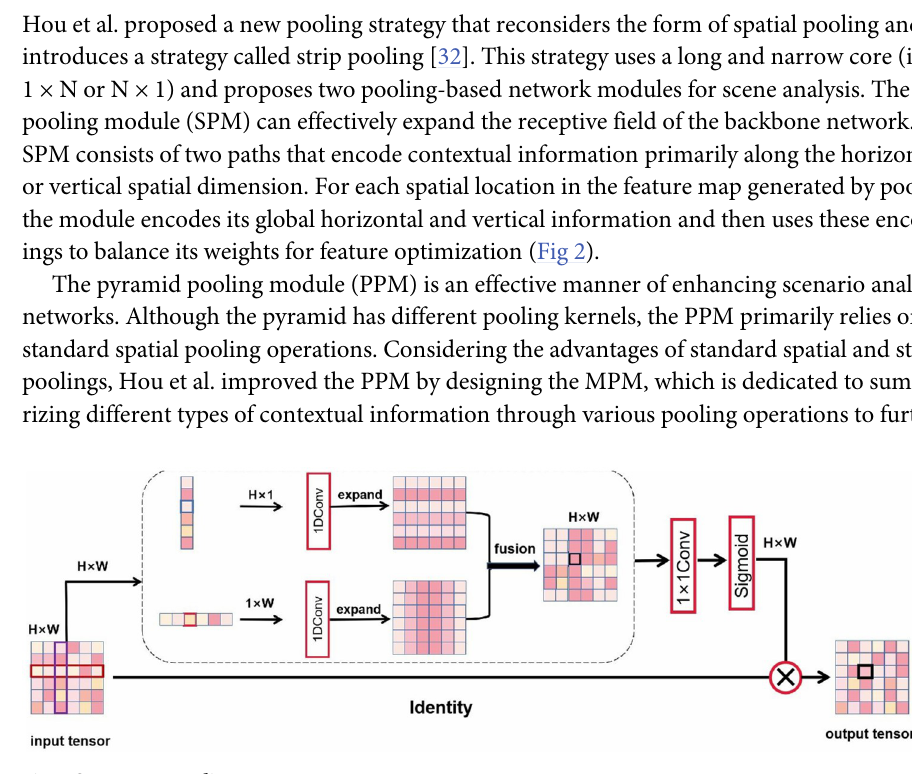
Fig 2. SPM structure